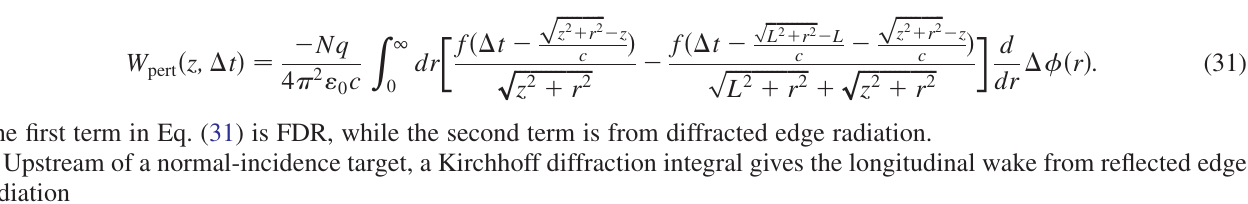
ffiffiffiffiffiffiffiffiffiffiffiffiffiffiffiffi p ffiffiffiffiffiffiffiffiffiffiffiffiffiffiffi L 2 þ r 2